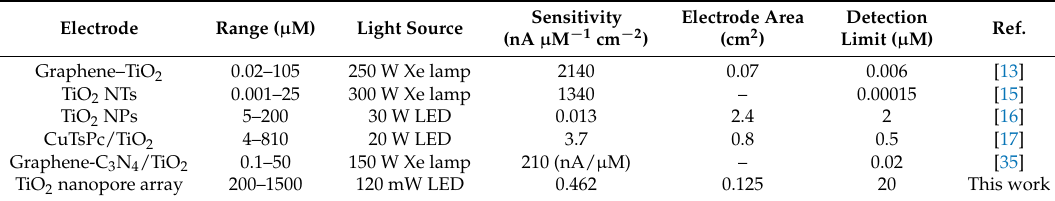
Table 1. Comparison of TiO 2 -based photo=electrochemical dopamine